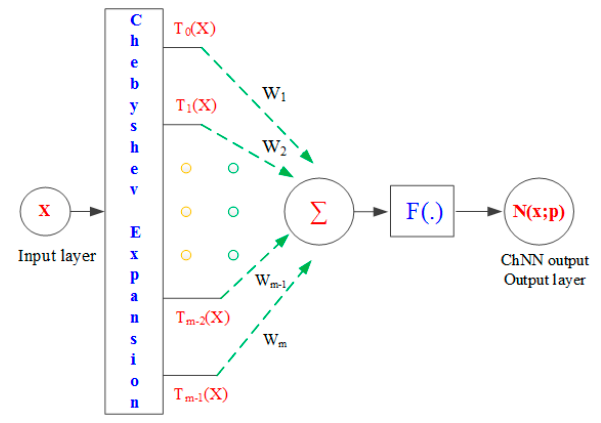
Figure 5. Simple Chebyshev neural network structure.